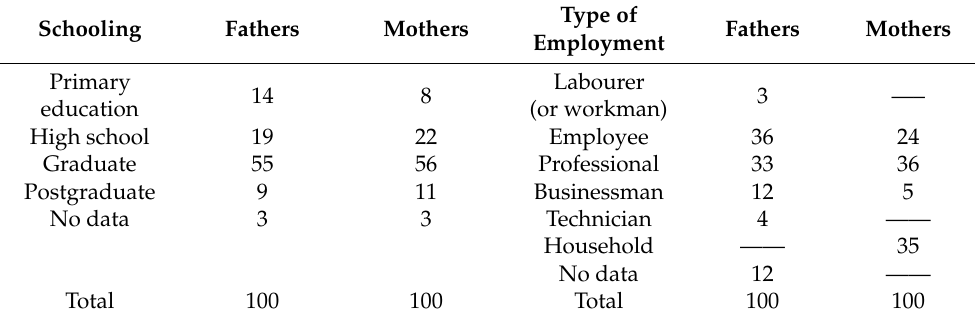
Table 1. Fathers’ and mothers’ schooling and type of